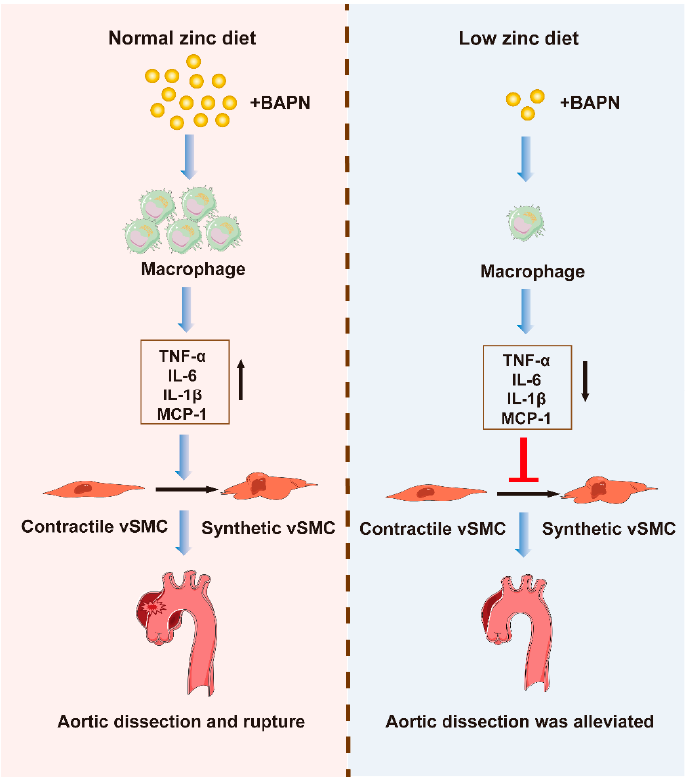
Figure 6. Schematic illustration of low zinc alleviated the progression of TAD. In BAPN-treated mice, compared with a normal zinc diet, low zinc treatment reduces the in fi ltration of macrophage, decreases the expression of cytokines and chemokines, and inhibits the phenotype switch from contractile VSMCs to synthetic VSMCs, eventually alleviating TAD development. Part of the elements in this fi gure uses resources from Servier Medical Art under a Creative Commons A tt ribution license. TAD indicates thoracic aortic dissection, and BAPN indicates β - aminopropionitrile monofumarate.